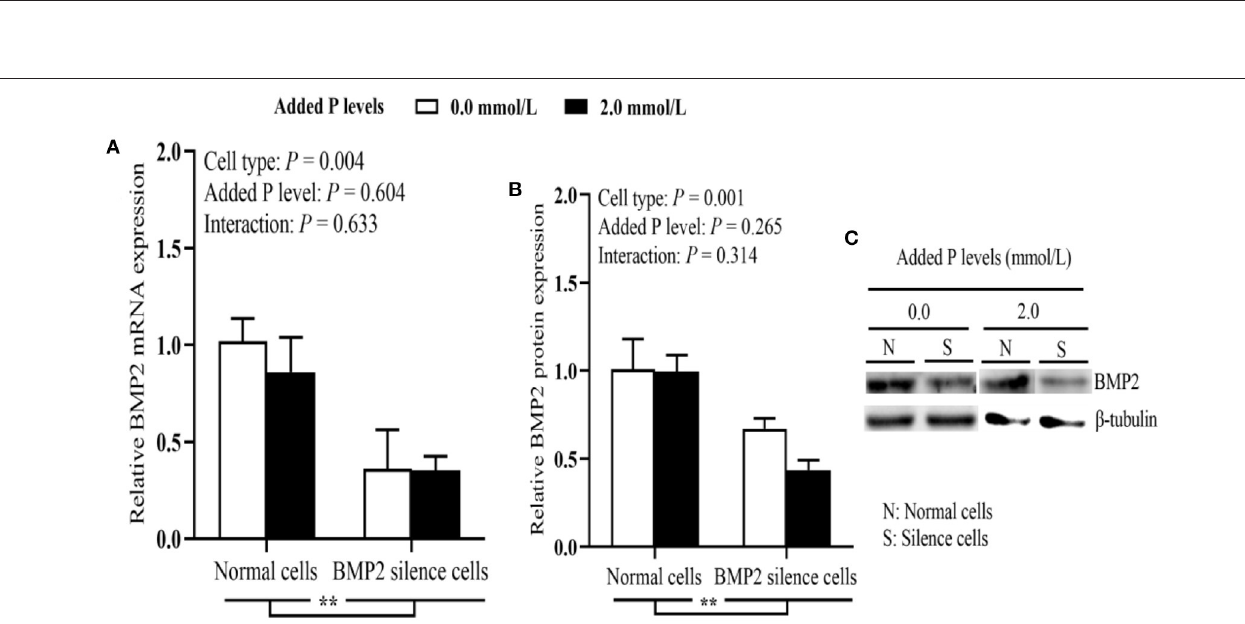
Frontiers in Veterinary Science |